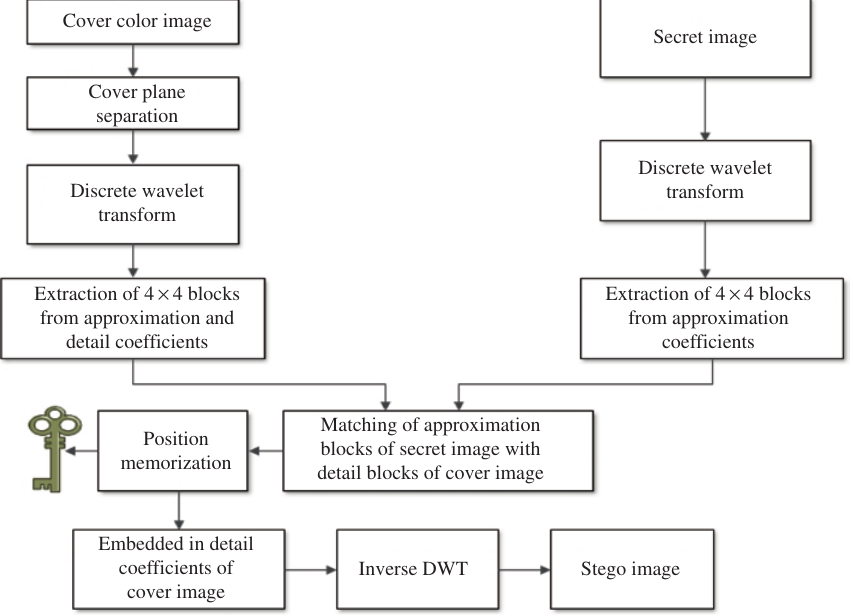
Figure 1: Proposed Embedding